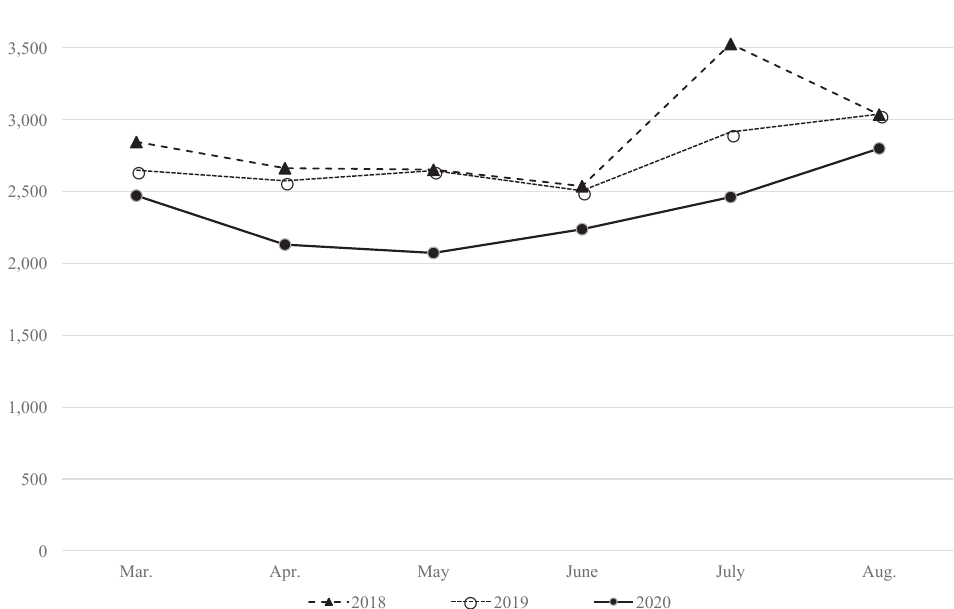
Figure 1. Monthly number of emergency dispatches in Okayama City and Kibichuo from March to August in 2018, 2019, and